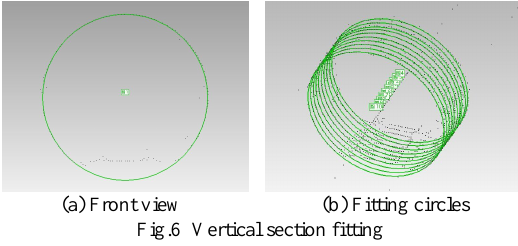
(b) Fitting circles Fig.6 Vertical section